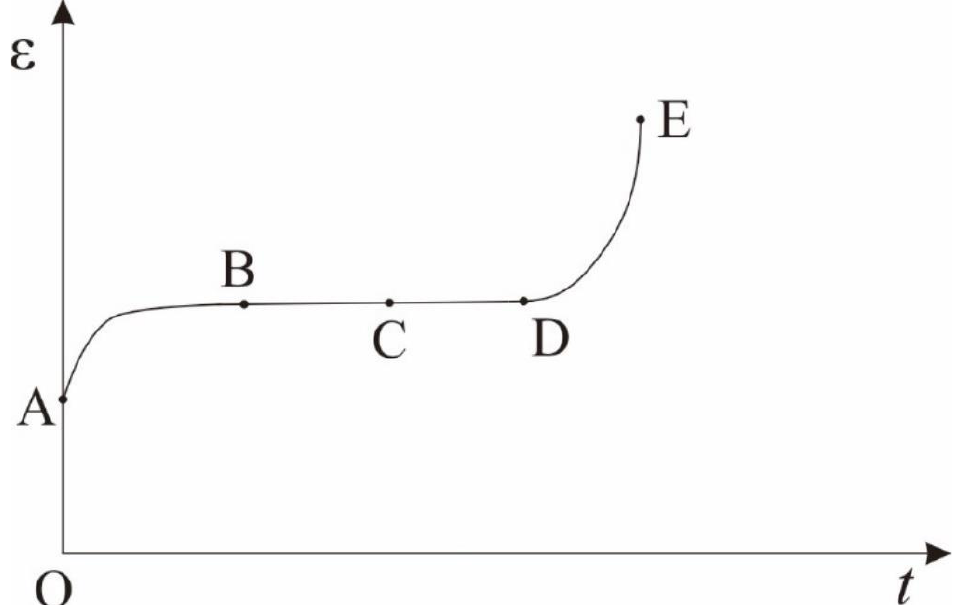
Figure 2. Typical loess creep curve.